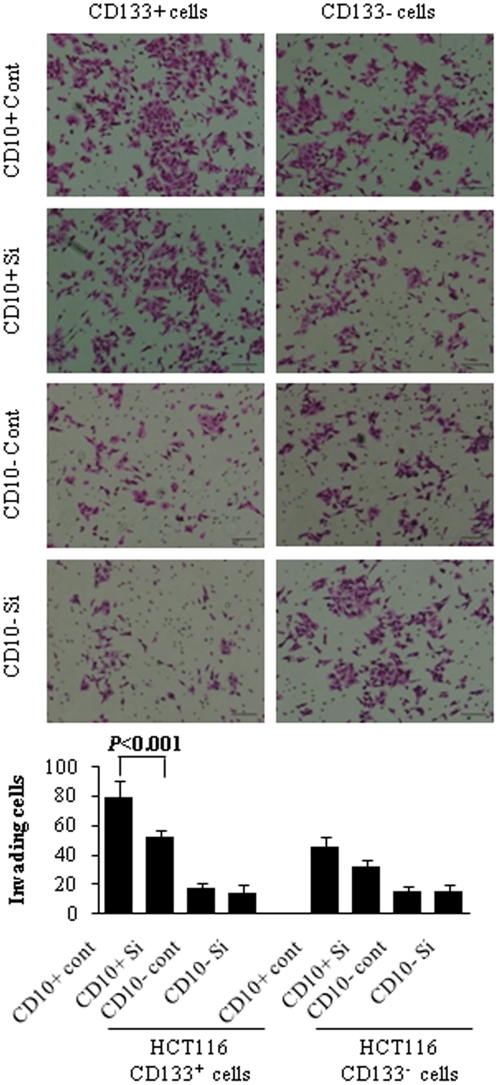
Invasiveness of CD133+ and CD133− HCT116 cells cocultured with fibroblasts transfected with control or CD10-targeting siRNAs.Knockdown of CD10 expression in CD10+ fibroblasts remarkably reduces the invasiveness of cocultured CD133+ HCT116 cancer cells (P<0.001), but has a limited effect on the invasiveness of CD133− cancer cells. Representative photographs (upper panels) and graphs (lower panel) are shown. Scale bars = 100 µm.